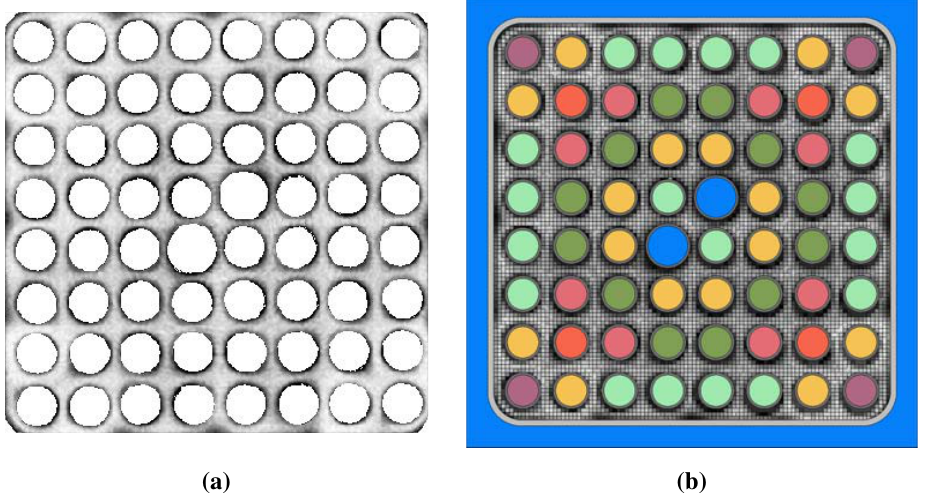
Figure 2: (a) Example of experimental data layout, lighter areas indicate areas of higher void fraction. (b) Example of processed Serpent 2 model based on same